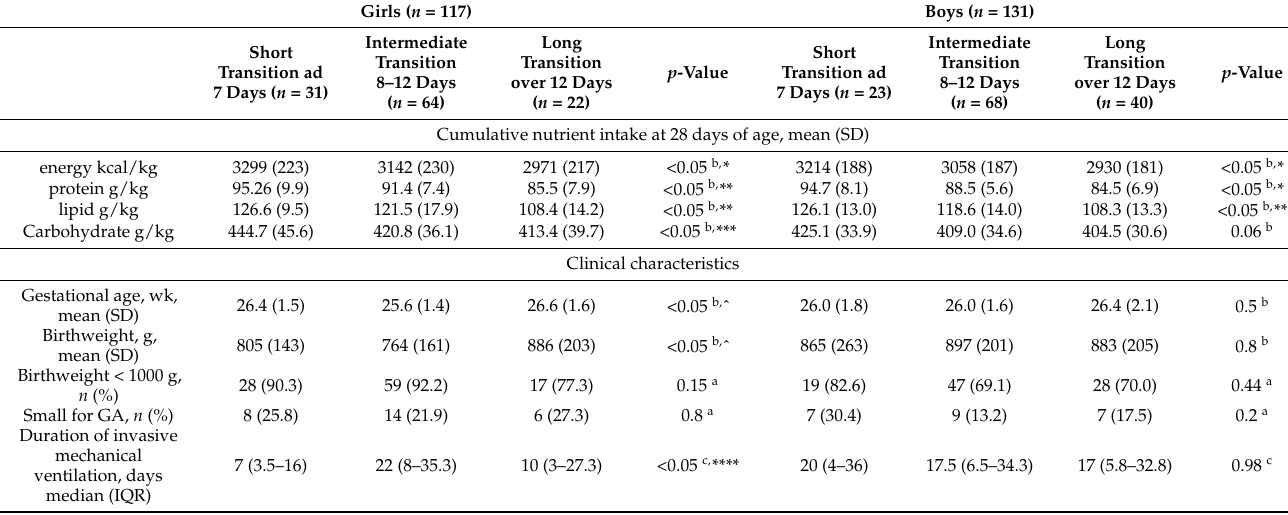
Table 2. Cumulative nutrient intake at 28 days of age and clinical characteristics of girls and boys according to the transition phase length